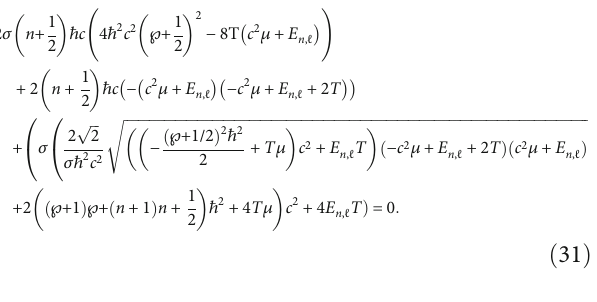
Figure 11: E ff ects of the Tsallis entropy for the position space S ð T Þ ð δ Þ with respect to the angular momentum quantum number p ℓ with μ = c = ℏ = 1 , Η = 20 , T = 10 , and ϱ = σ = 0 : 1 for D = 3 :